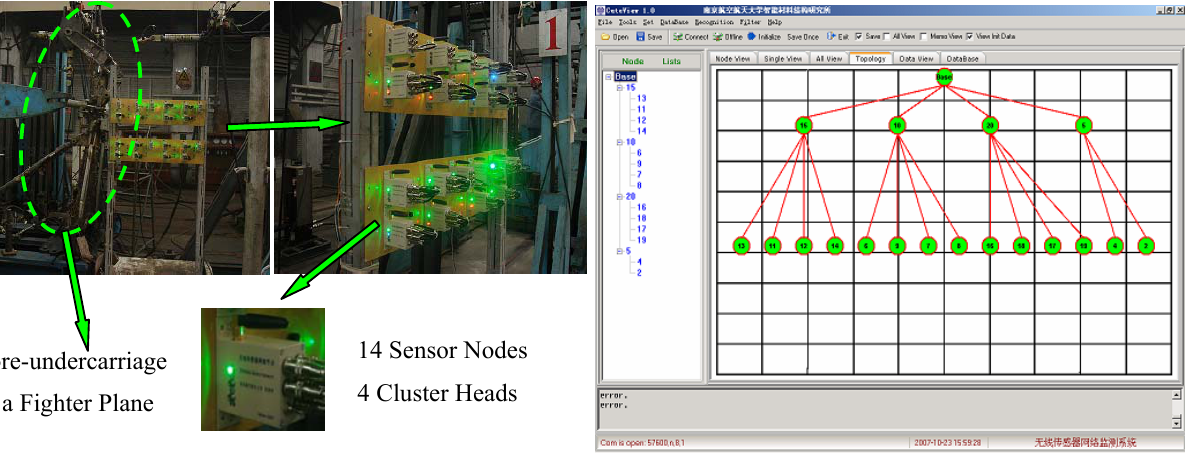
Figure 13. (a) Field setup of the wireless sensor network system. (b) Monitoring interface of the network system.